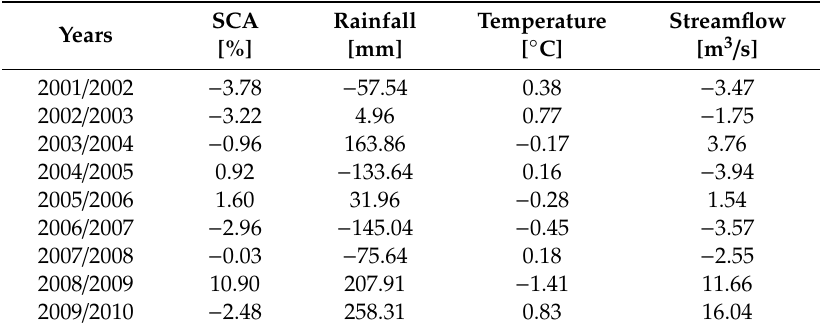
Table 1. Interannual variability of median Snow Cover Area (SCA), total rainfall, average temperature, and average streamflow anomalies over the study